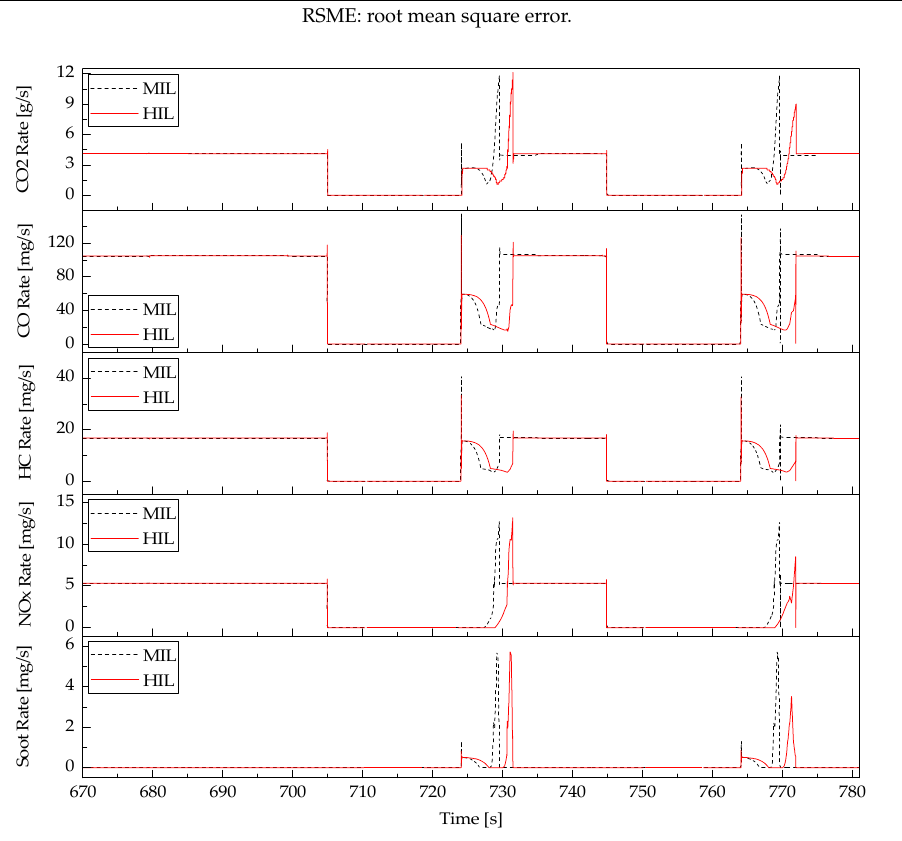
Figure 14. Comparison of ICE emission rates of MIL and HIL tests during cycle 7th.